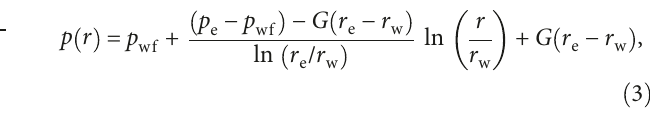
Table 1: Basic parameters of cores in rock compressibility stress sensitivity